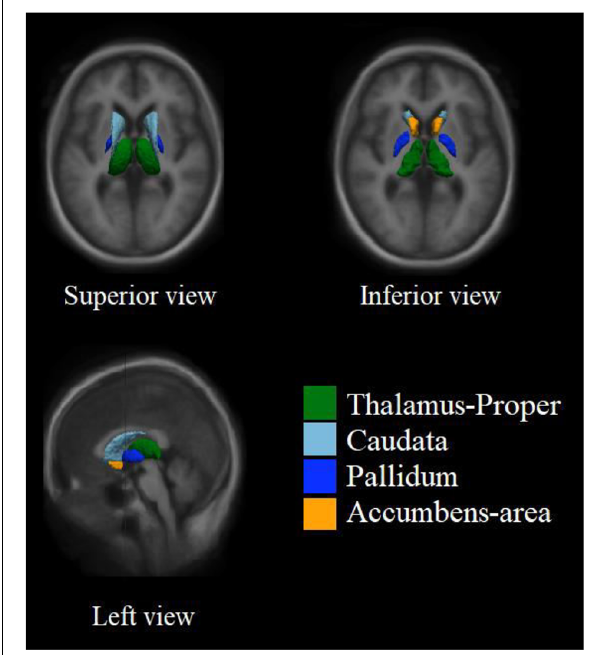
FIGURE 1 | Example location of four subcortical nucleus in the brain. The spatial distribution of subcortical nucleus with volume differences in the standard brain was showed. The thalamus, located on both sides of the third ventricle, is the largest of these subcortical nucleus. Pallidum is located in the anterior inferior part of thalamus. The caudate is located in the front and upper part of pallidum. The accumbens is located in the lower part of caudate and the anterior part of